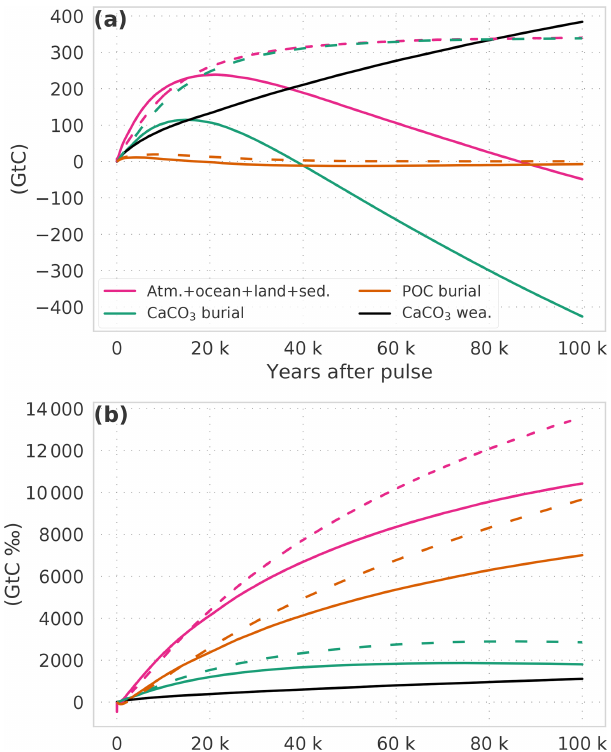
Figure 4. The perturbation budget for (a) carbon and (b) car- bon isotopes. Solid lines show results from experiment WEA 500 ; dashed lines are from experiment SED 500 . (a, b) The pulse (500, − 12000GtC‰) is subtracted from the combined atmosphere– ocean–land-reactive sediment inventory. Burial fluxes are plotted inversely, and the sum of burial (green, orange lines) and weath- ering (black) fluxes yields the combined inventory